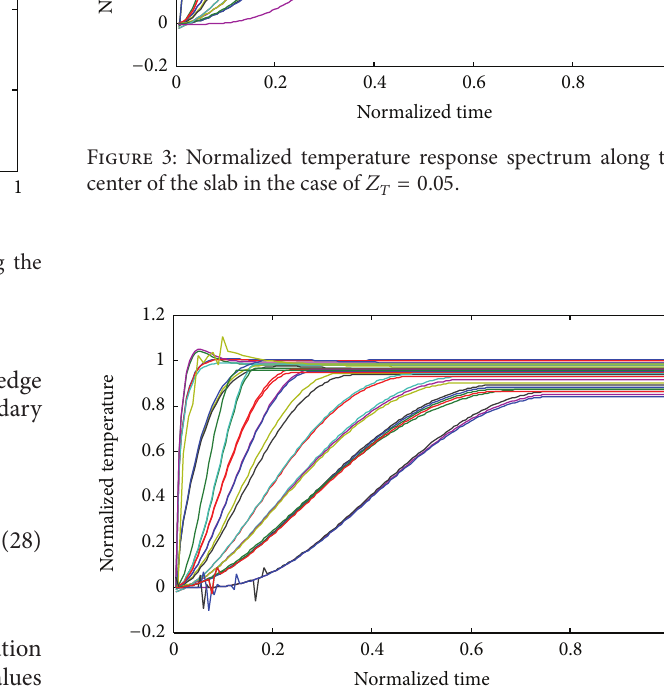
Figure 4: Normalized temperature response spectrum along the center of the slab for the case of 𝑍 𝑇 = 0.0001 .